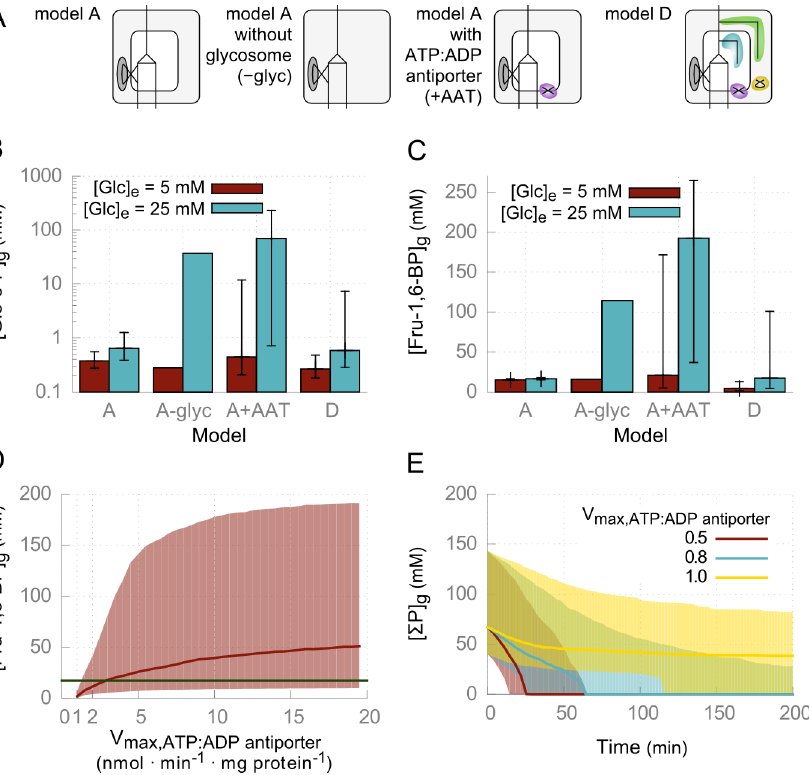
Figure 3. ATP:ADP antiporter mimics turbo-state. ( A ) Overview of the models used in this figure. Model A and D are from Figure 1, model A– glyc is model A without glycosomal localization, as described in [31], model A + AAT is model A with an ATP:ADP antiporter. ( B–C ) Steady-state concentrations of glycosomal Glc-6-P and Fru-1,6-BP are depicted in the various models. ( D ) Increasing the activity of the ATP:ADP antiporter (V max,ATP:ADP antiporter ) in model D leads to a high risk of accumulation of hexose phosphates. The green line indicates the concentration of Fru-1,6-BP in the original model of glycolysis (17.2 mM, panel C, model A). Glc e in this simulation is 25 mM. ( E ) Time course simulation of model D at 25 mM Glc e and various values for the V max,ATP:ADP antiporter parameter. Plotted is the concentration of glycosomal phosphates ( S P similar as in Figure 2, moiety 5 in Table 2). ATP:ADP antiporter activity values below 1 nmol ? min 2 1 ? mg protein 2 1 result in depletion of glycosomal phosphates (cf. Figure 2). k TOX =2 m l ? min 2 1 ? mg protein 2 1 in all models. Solid lines indicate medians, shaded areas and error bars show interquartile ranges, as derived from the uncertainty modeling.